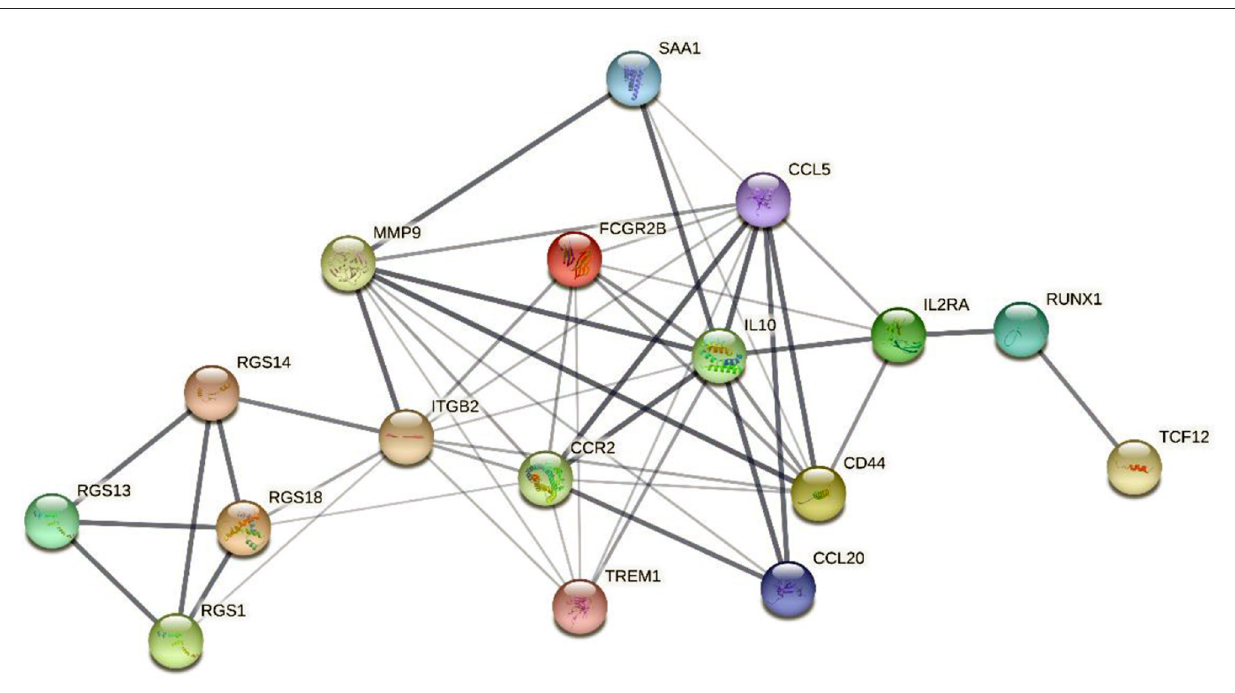
FIGURE 9 | The interaction network map of 5 marker genes. The network nodes represent the protein types, the edges represent protein–protein associations, and the line thicknesses represent the strength of the data supporting the interaction between the